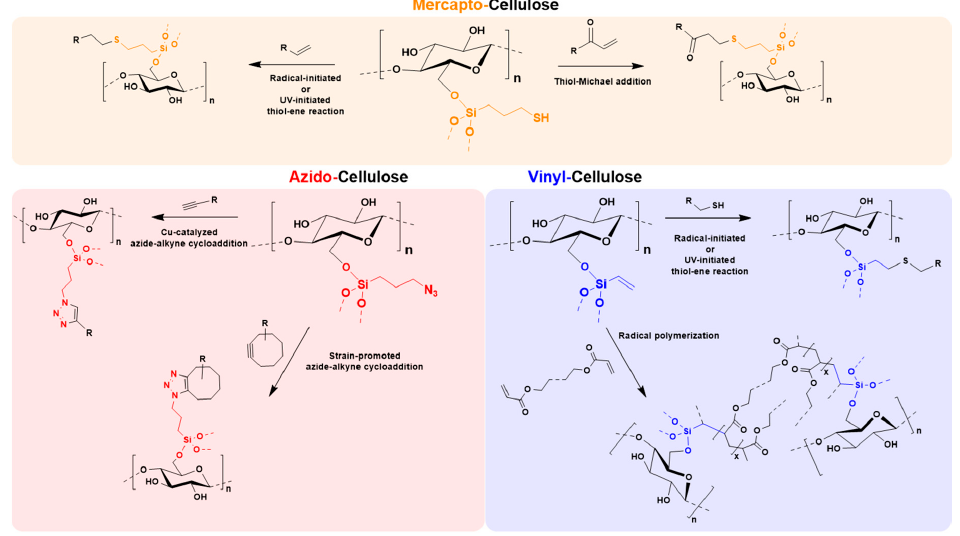
Figure 8. Towards a multi-purpose toolbox for modification of never-dried celluloses. Overview of possible post modification strategies for the synthesized mercapto-, azido, and vinyl-celluloses.